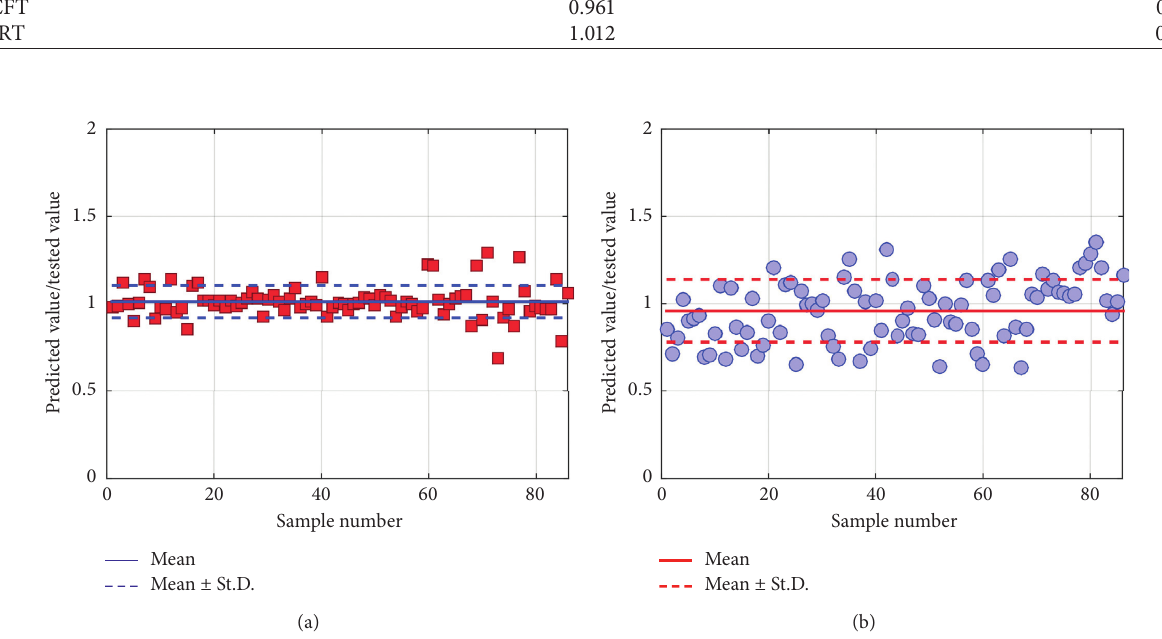
Figure 6: Comparisons of shear strength of RC joints by the GBRTpredictive model and MCFTmodel. (a) GBRTresults. (b) MCFTresults. Table 7: Statistic results of predicted value/tested value ratios for the MCFT and GBRT models. Model Mean value St.D. 0.961